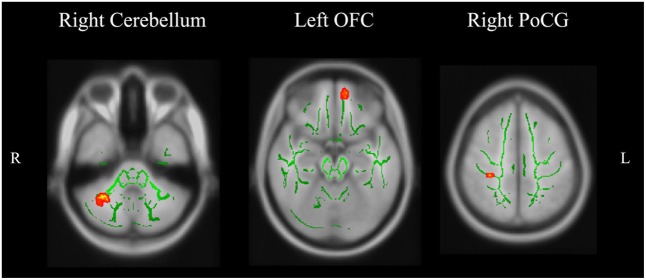
Brain regions showing significant differences of FA among the three groups.